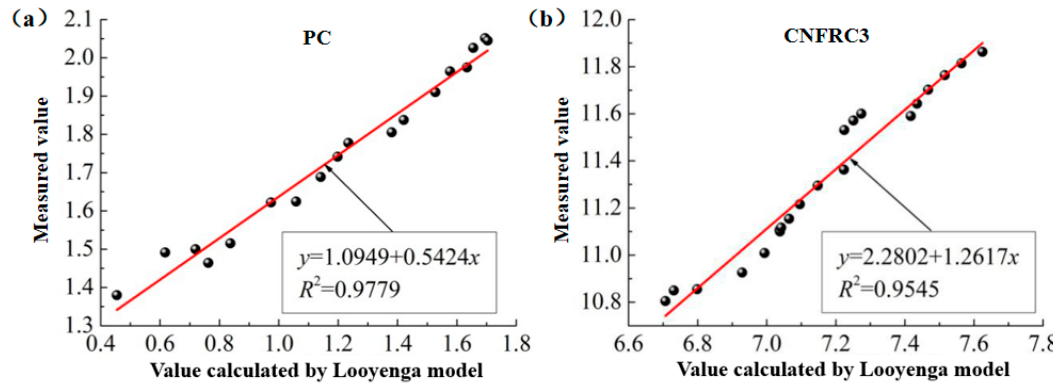
Figure 15. The fitting for relation between measured values and calculated values for ε ,, based on Looyenga model. ( a ) PC; ( b ) CNFRC1.